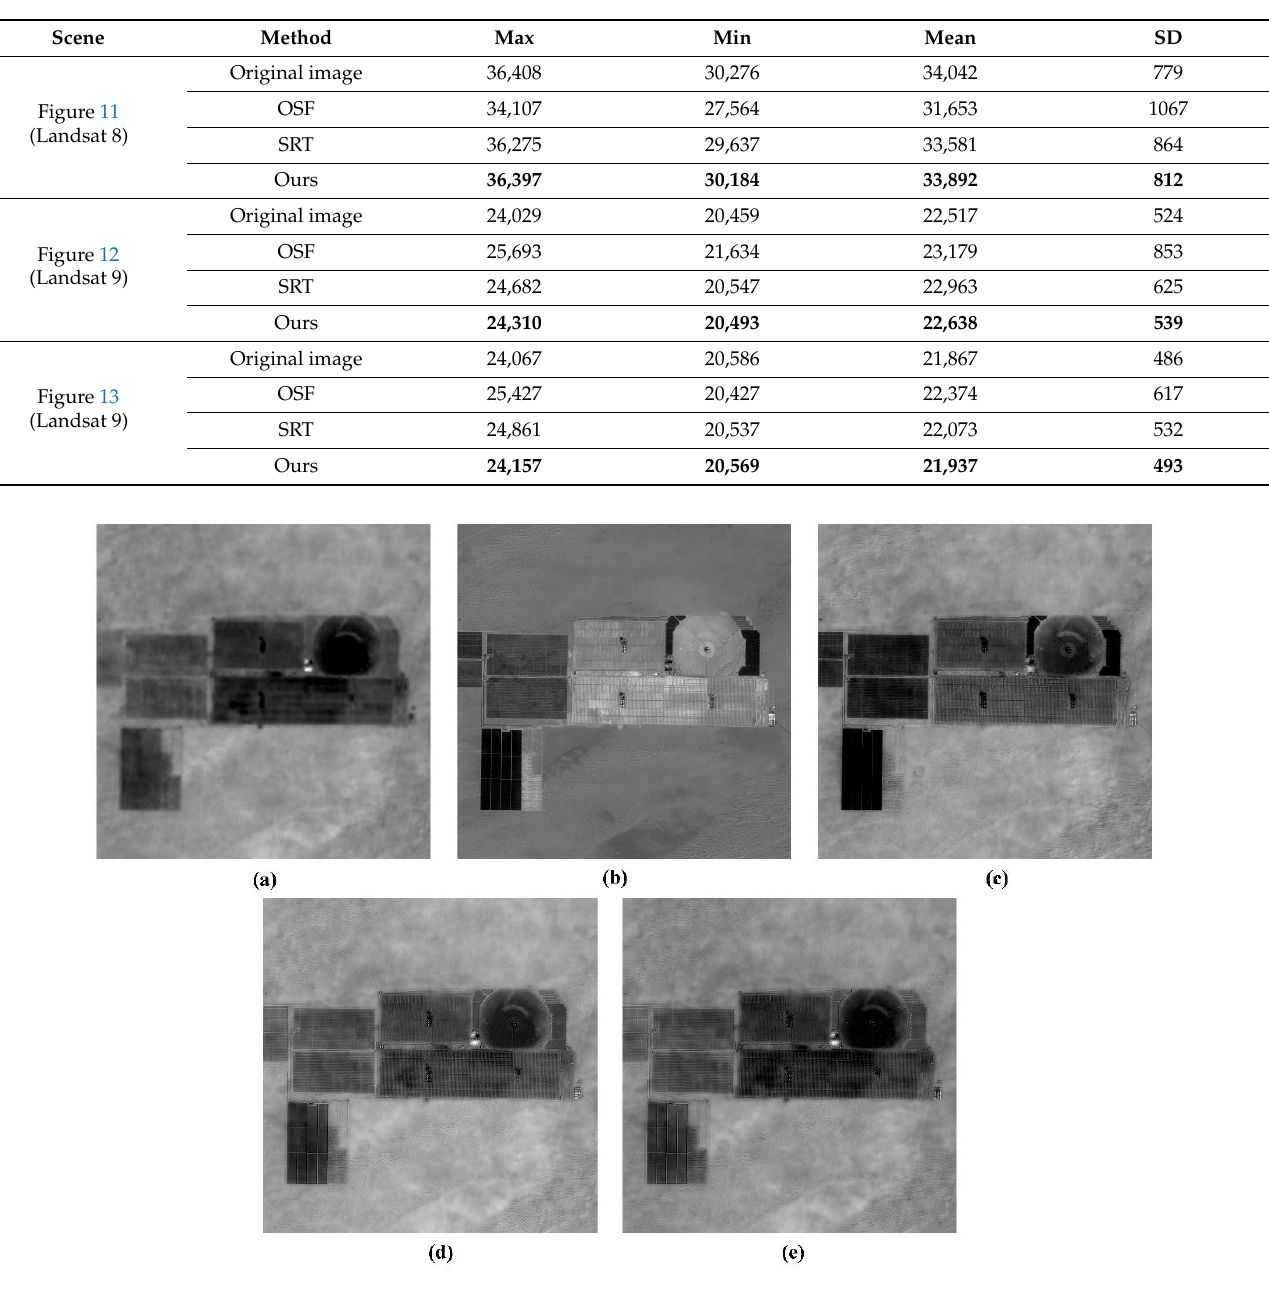
Table 3. Summary of some statistics of thermal infrared images before and after fusion.